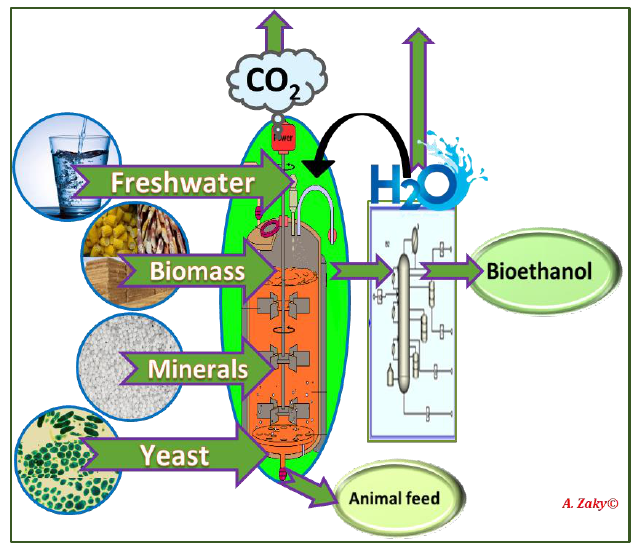
Figure 1. Inland-freshwater-biorefinery (IFB)